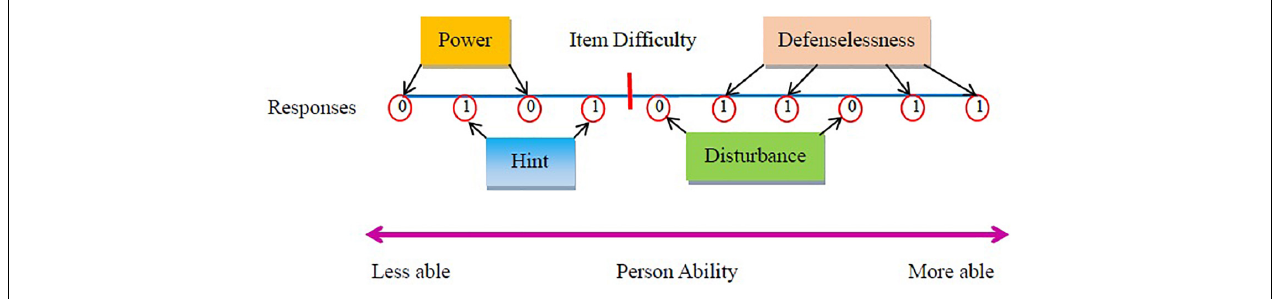
FIGURE 1 | Ideas of the four Poly-BW indices beyond and within item